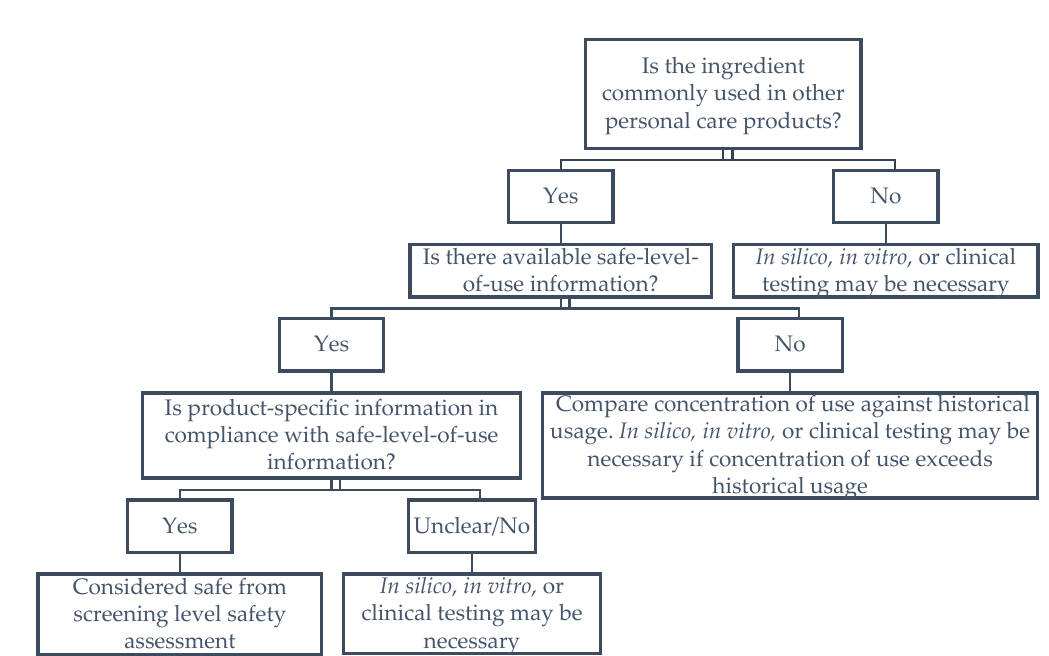
Figure 1. Screening level safety assessment framework.